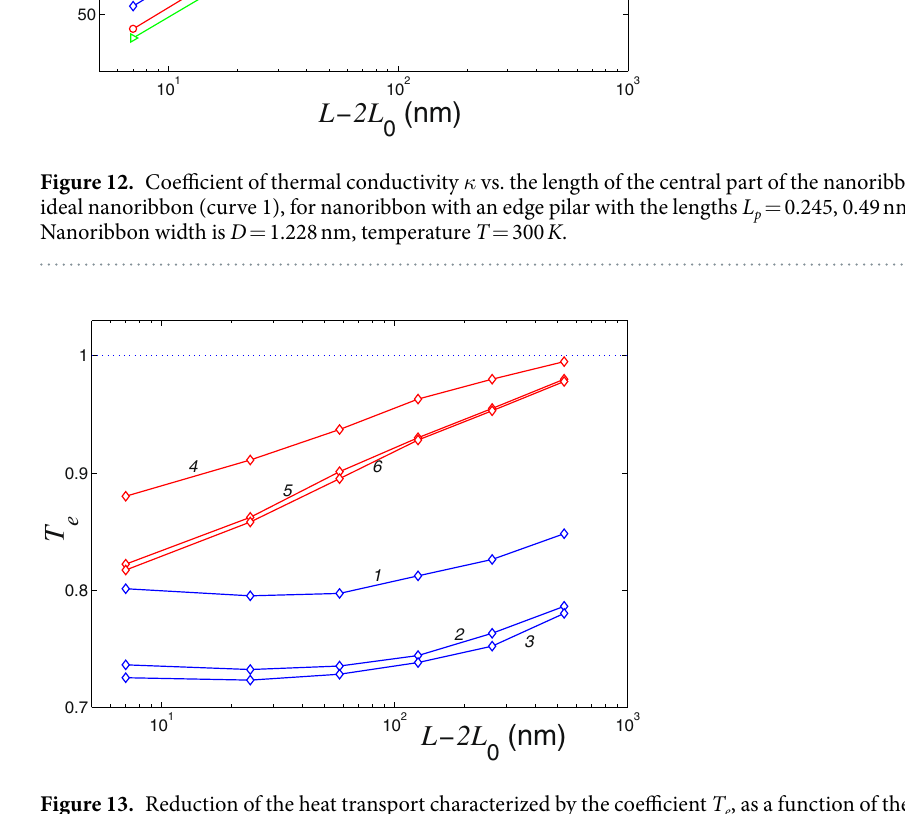
Figure 13. Reduction of the heat transport characterized by the coefficient T e , as a function of the nanoribbon length L in the nanoribbon with an edge pilar with the lengths L p = 0.246, 0.49, 0.98 nm for temperature T = 3 K (curves 1, 2, 3) and T = 300 K (curves 4, 5, 6). Width of the nanoribbon is D = 1.228